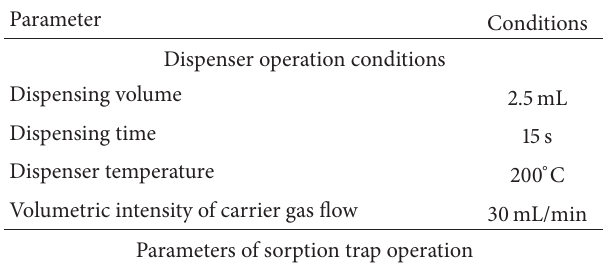
Table 1: Parameters of electronic nose operation.